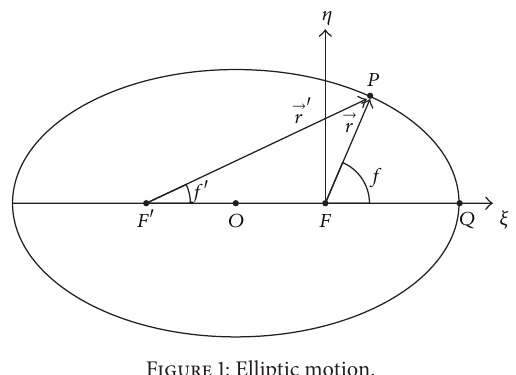
Figure 1: Elliptic